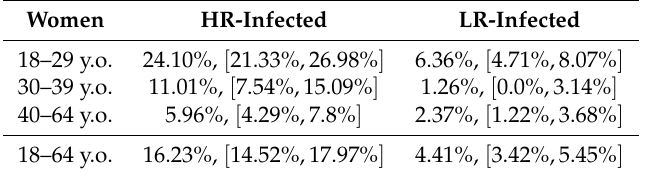
Table 2. Prevalence of HR- and LR-infected women per age groups from the CLEOPATRE study [3]. Co-infections are included in both HR- and LR-infected, mean and 95% confidence